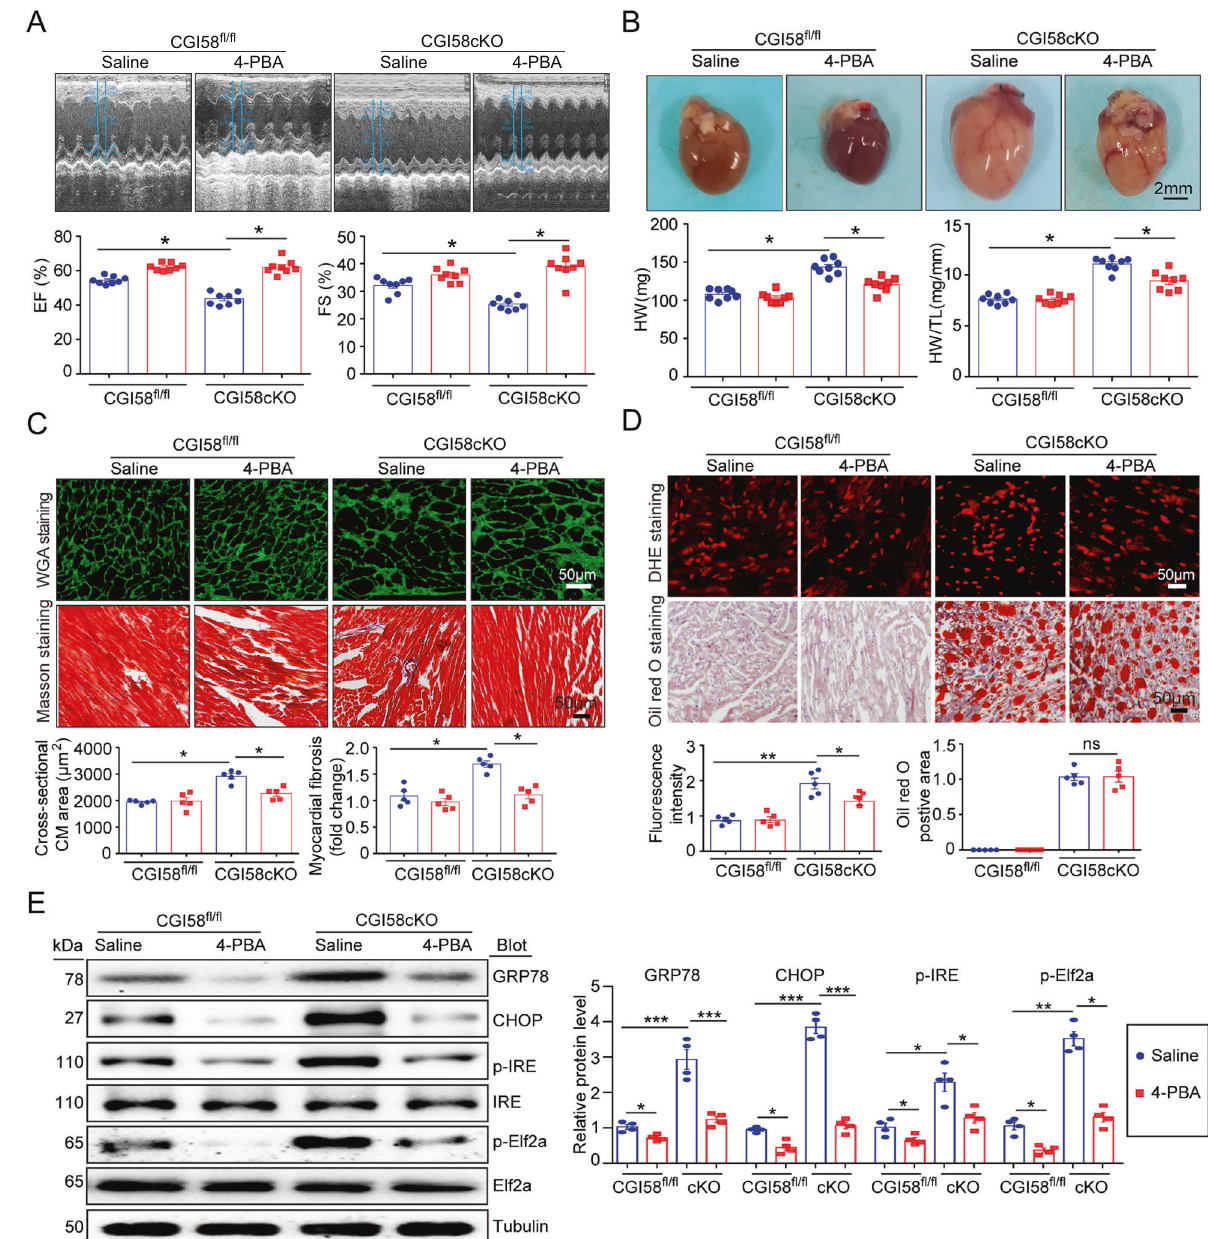
Fig. 7 Administration of 4-PBA inhibits cardiac hypertrophic remodeling and dysfunction in CGI-58 cko mice. A M-model echocardiography of the left ventricle (upper). Measurement of EF% and FS% (lower, n = 8). B Heart size (upper), heart weight, and HW/TL ratio (lower, n = 8). Scale bar 2 mm. C FITC-labeled WGA staining or Masson ’ s Trichrome staining of the heart sections (upper). Quanti fi cation of the relative myocyte cross-sectional area and fi brotic area (lower, n = 5). D DHE or Oil Red O staining of the heart sections (upper), and the quanti fi cation of ROS and lipid levels (lower, n = 5). Scale bar 50 μ m. E Western blot analysis of GRP78, CHOP, p-IRE, and p-Elf2a protein levels (left), and the quanti fi cation of relative protein level (right, n = 4). Data are presented as mean ± SEM, and n represents the number of samples or animals. * P < 0.5, ** P < 0.01, *** P < remodeling and contractile dysfunction accompanied by increased TG levels, ROS production, protein glycosylation, and oxidation, whereas the expression levels of regulators of FA metabolism (ATGL, PPAR α , CPT-1m, HMGCS2, and LCAD) were reduced in the heart of CGI-58 cko mice under ND and HFD conditions (Figs. 2 and 5). However, these effects were restored in CGI-58 cko mice injected with rAAV9-CGI-58 (Fig. 3). It should be emphasized that our data were obtained from cardiac-speci fi c CGI-58-de fi cient mice (CGI-58 cko mice) and better explain the effect of CGI-58 on the heart.